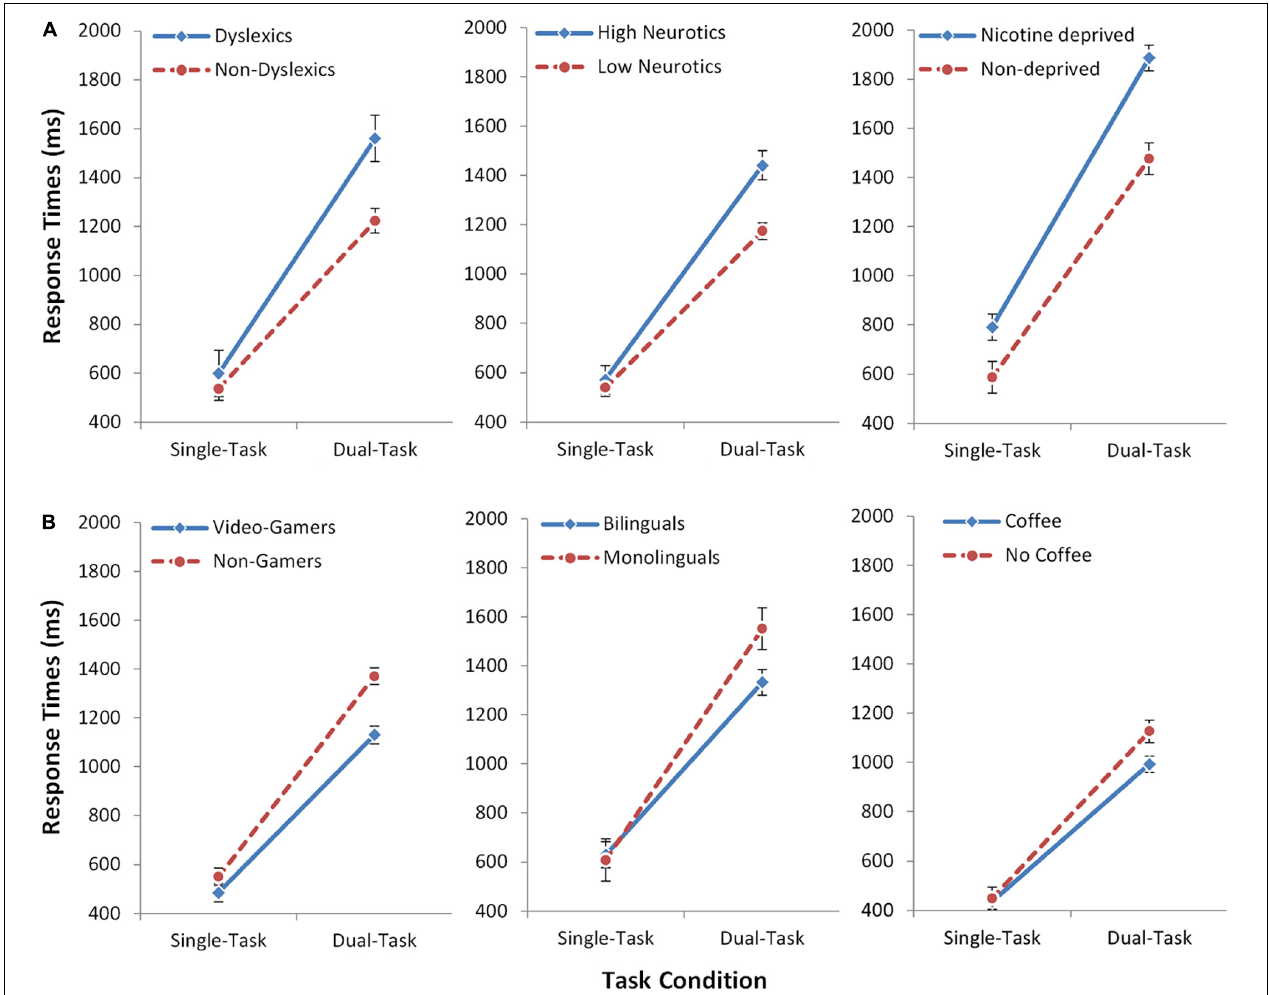
FIGURE 2 | Experiment Series 1. Response times (ms) for the three independent groups of participants who are known to have impaired executive functions [upper panel, (A) ] and for the three groups who are known to have improved executive functions [lower panel, (B) ]. Dual-task costs are the relative slowing of response times in the dual-task (RT2) as compared to the single-task. Effects specific to multitasking are evident by increased or decreased dual-task costs, respectively, reflected in the interaction. Error bars show standard error of the mean